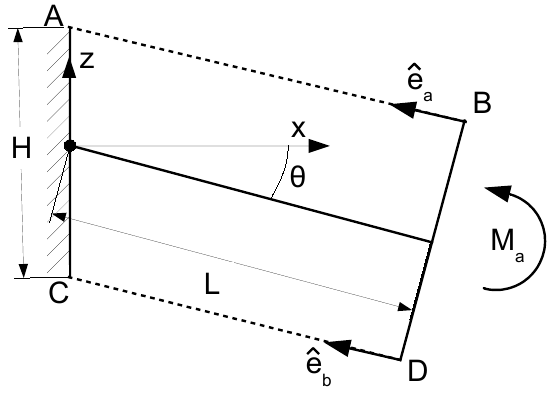
Figure 12. The model of the antagonistic bender comprises a pair of bowtie actuators (shown as dashed lines) attached to a “T”-shaped frame pinned to ground. The figure shows the AB bowtie actuated (thus extended) and the unactuated CD bowtie contracted. The M represents the torque load on the actuator. Unit vectors ˆ e bowtie elastic